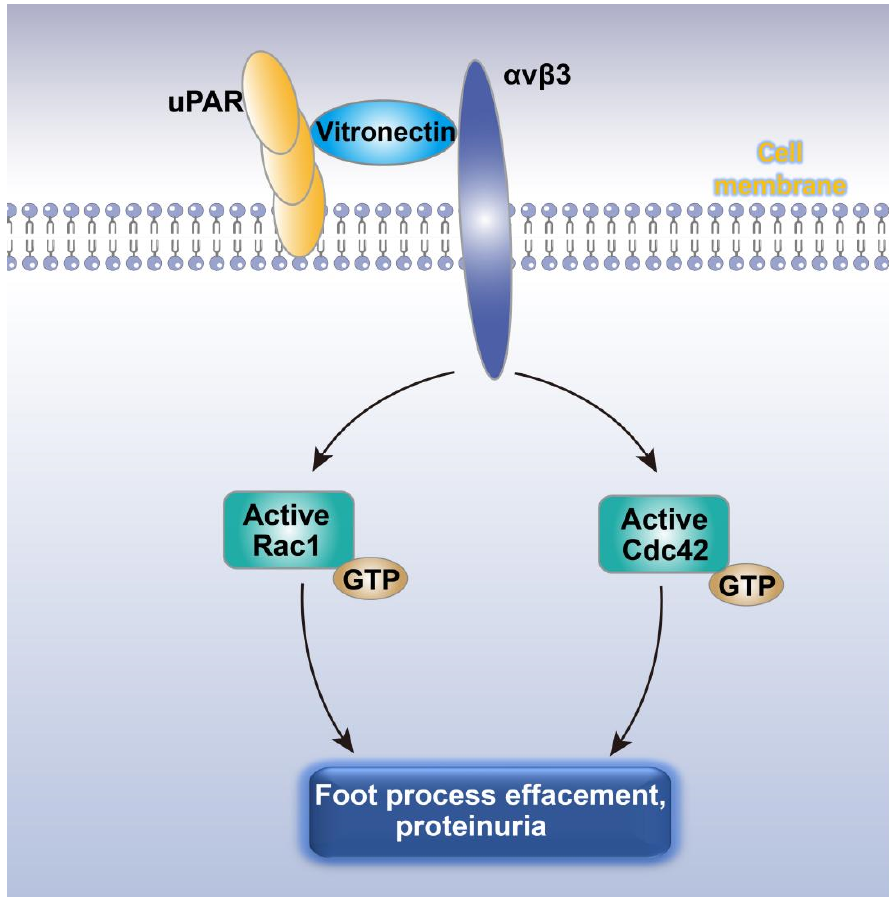
Figure 3. uPAR-αvβ3 pathway mediated foot process effacement and proteinuria through Rac1 and Cdc42. uPAR activates αvβ3 integrin through vitronectin in the lipid-rich domain of the plasma membrane of podocytes, mediates the increase in Cdc42 and Rac1 activity, and induces foot process fusion and proteinuria. uPRA, urokinase receptor.